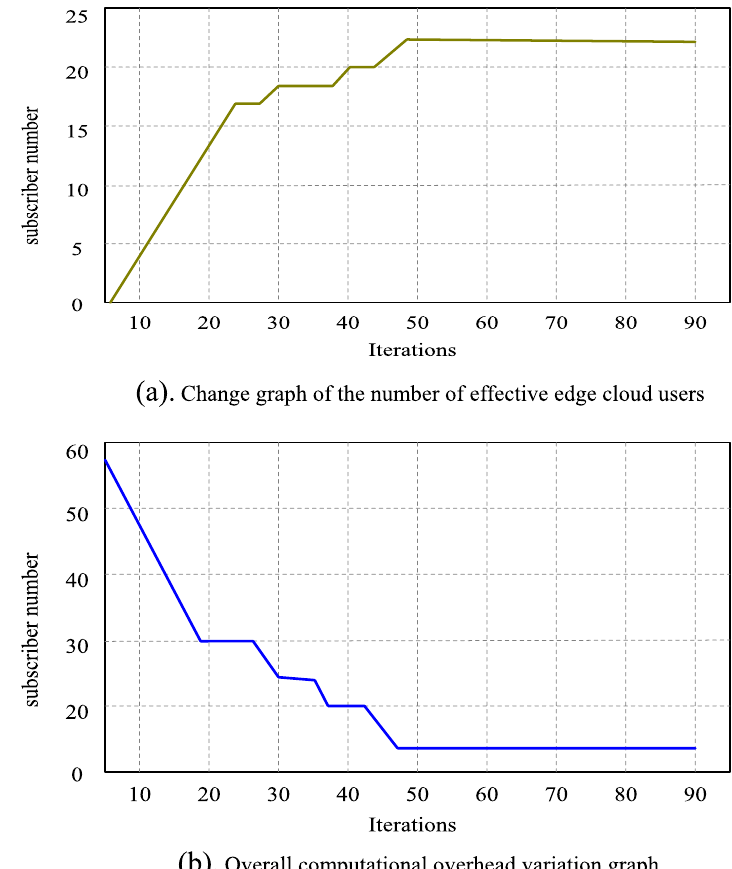
Fig. 9 Change graph of user number of effective edge cloud and overall computing overhead change graph